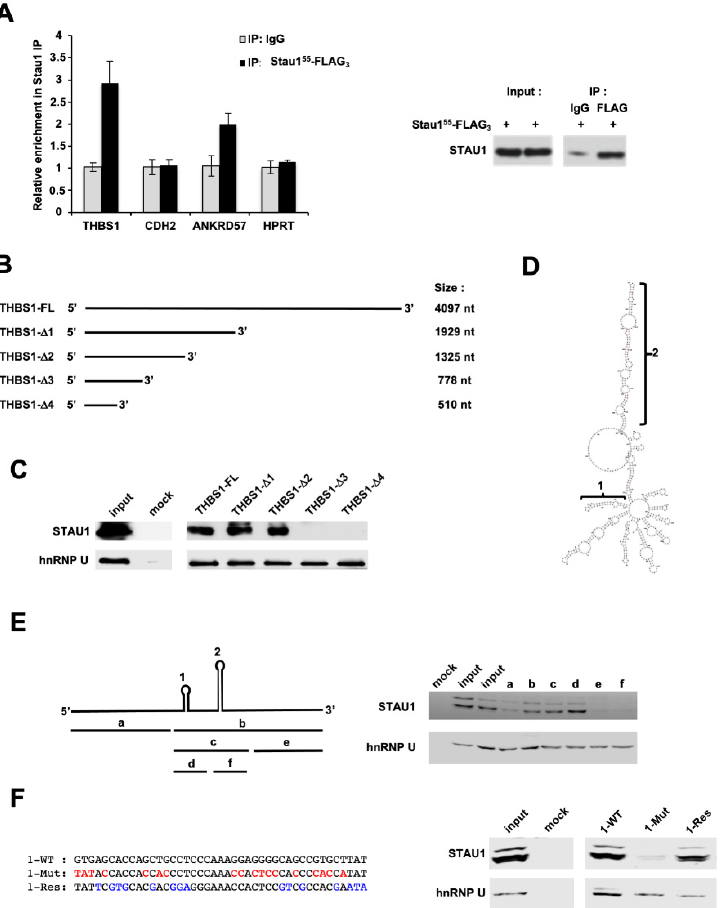
Figure 7. Stau1 binds to THBS1 mRNA. ( A ) RNA immunoprecipitation of THBS1 mRNA by Stau1, but not CDH2 mRNA (left). ANKRD57 and HPRT were used as a positive and a negative control, respectively. Western blot analysis was performed to control immunoprecipitation (right). ( B ) Deletion constructs of THBS1 3 ′ UTR mRNA used to map the Staufen Binding Site (SBS). ( C ) Stau1 pull-down by the indicated portions of THBS1 3 ′ UTR mRNA. ( D ) Prediction of the 547 nt sequence containing the SBS. ( E ) Precise mapping of Stau1 SBS in the “b” portion on the 547 nt fragment by RNA pull-down. ( F ) Mutagenesis confirmed that the “b” portion corresponds to the SBS as Stau1 did not bind to the 1-Mut construct, but 1-Res restored Stau1 binding.